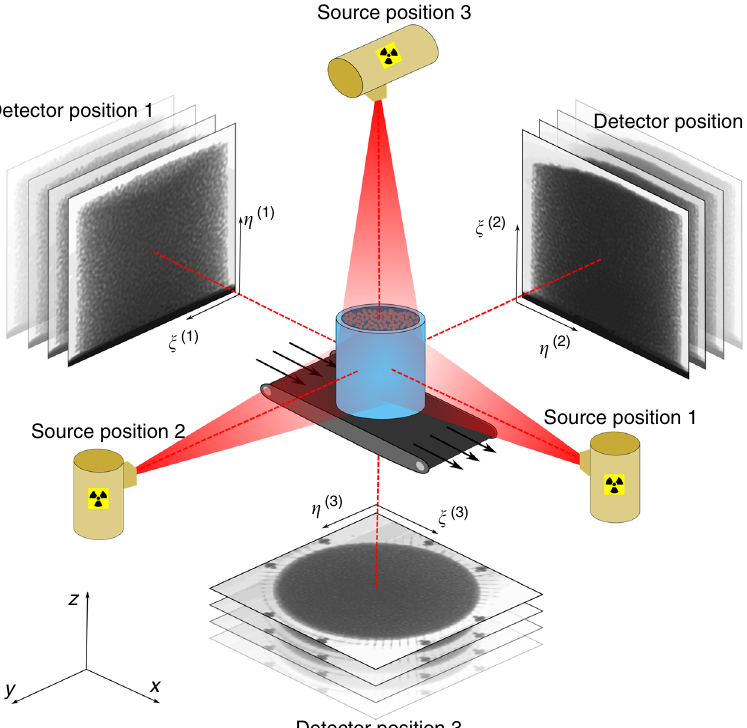
Fig. 1 Schematic diagram of the experimental set-up. Con fi ned granular material lies inside the blue cylinder, which is sheared from below in the direction indicated. The three X-ray source positions are shown in yellow, with red indicating the approximate extent of beams, and greyscale images representing radiographic acquisition at the corresponding detector positions. Also shown for reference are the global ( x , y , z ) and local imaging coordinates ( ξ , η